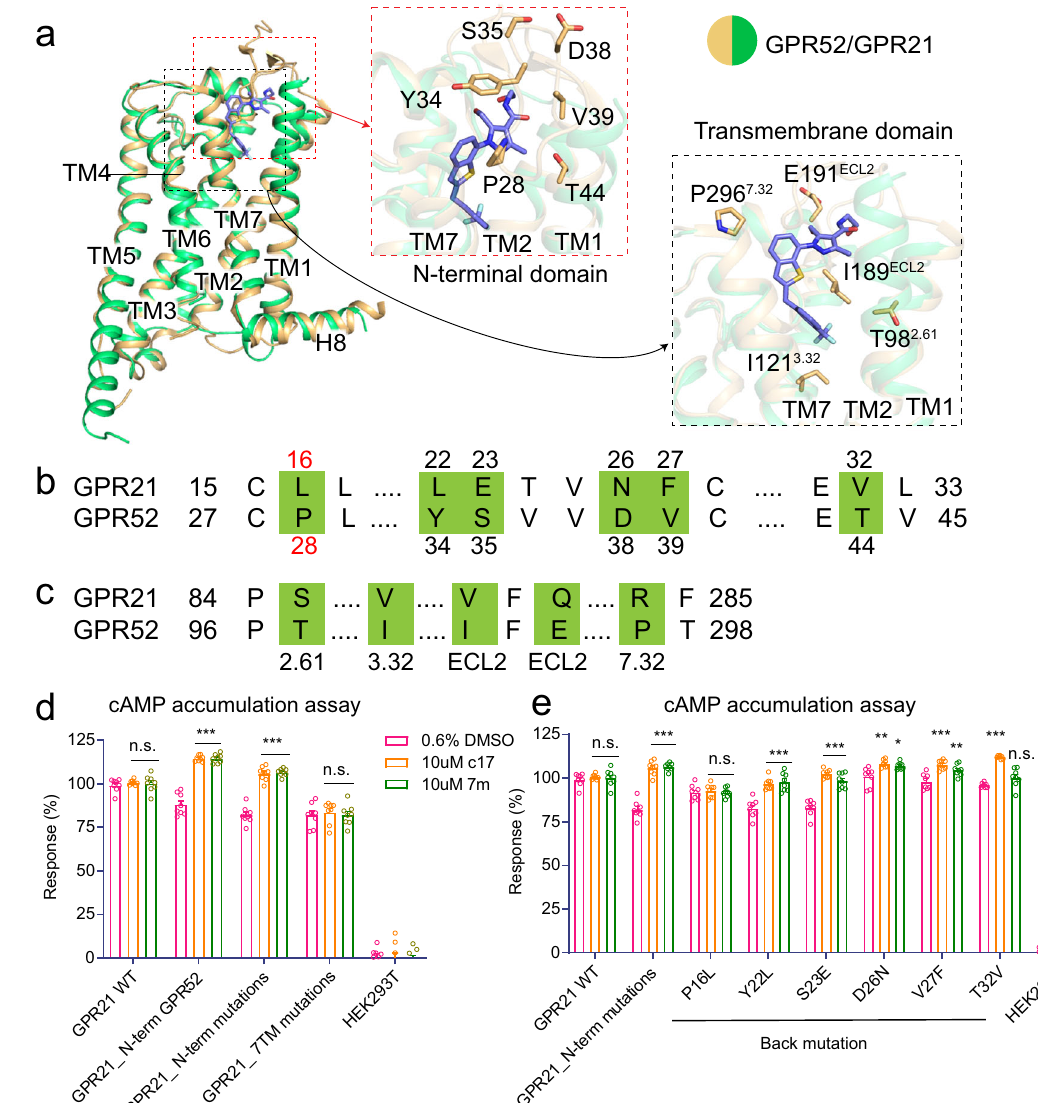
Fig. 3 | Key residues for ligand recognition in the side pocket. a Side and close- upviewsofthesidepocketbetweenGPR21(green)andGPR52-c17structure(gold). Key residues of N-terminal and transmembrane domains on GPR52 are shown as sticks.c17(purple)isshowninthesidepocketassticks. b , c Sequencealignmentof part of the N-terminal domain ( b ) and transmembrane domain ( c ) in GPR21 and GPR52. Key residues of side pocket are coloured in green. d Effects of GPR21 side pocketmutationsonligandbindingofGPR52 ’ sagonists(c17and7m)comparedto DMSO-response at WT GPR21 receptor or mutants measured by cAMP accumula- tion assay (see Methods). Mutants include: replacing residues 1 – 28 of GPR21 with residues1 – 40ofGPR52basedonWTGPR21(GPR21_N-termGPR52);mutating6key residues (L16P, L22Y, E23S, N26D, F27V and T32V) of the N-terminal domain